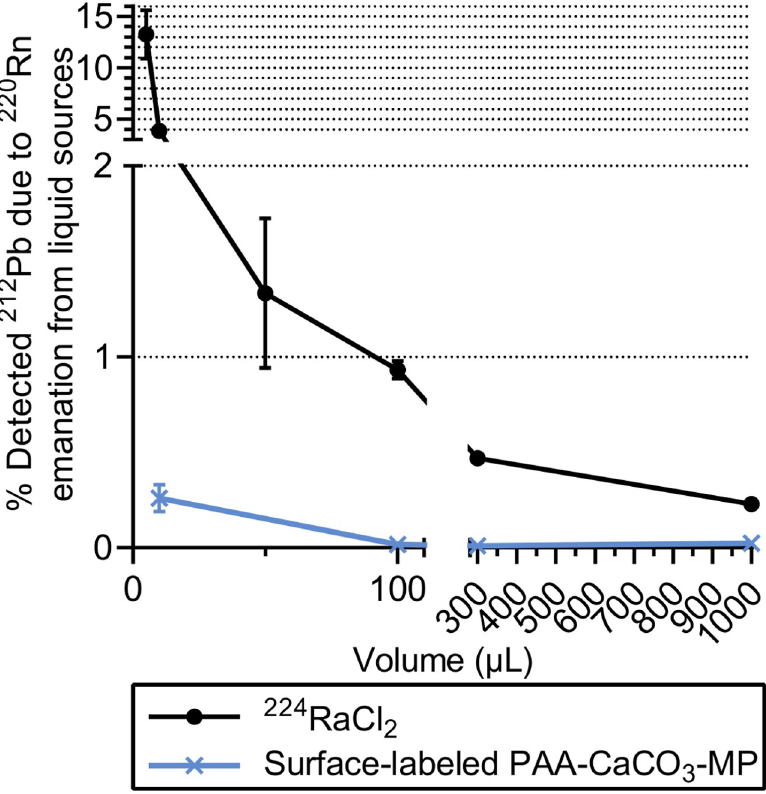
Fig 4. Detected 212 Pb due to 220 Rn release from open liquid sources of 224 Ra approximately 1 day after assembly. Sample volumes ranged from 5 to 1000 μ L of either free cationic 224 Ra or suspensions with 4.3 mg PAA-coated CaCO 3 microparticles surface labeled with 224 Ra. Error bars represent standard